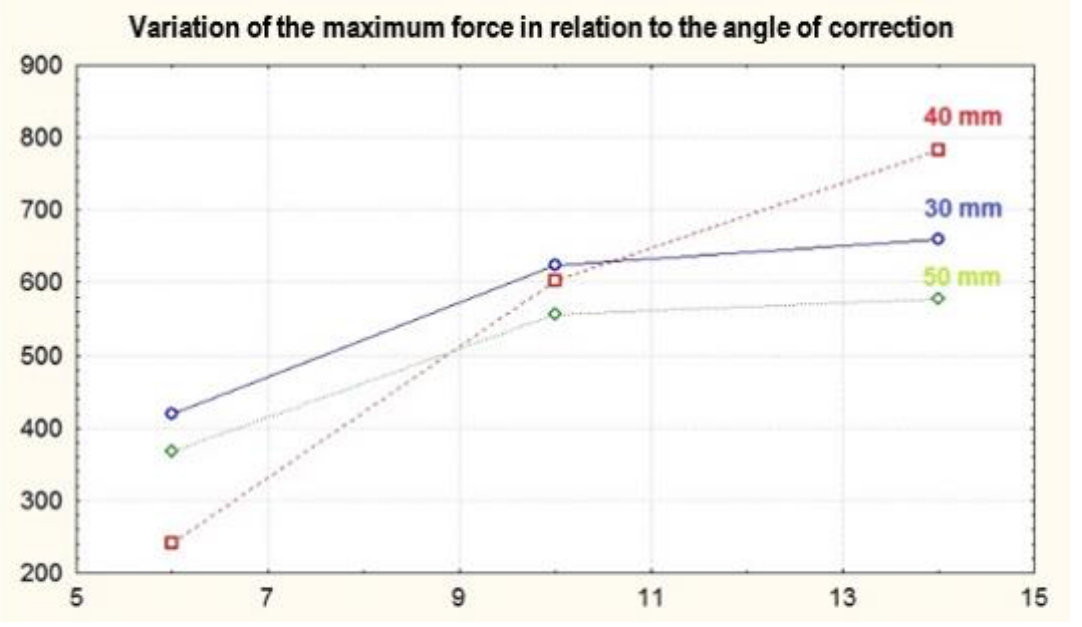
Figure 10. Variation of the maximum force in relation to the correction angle.